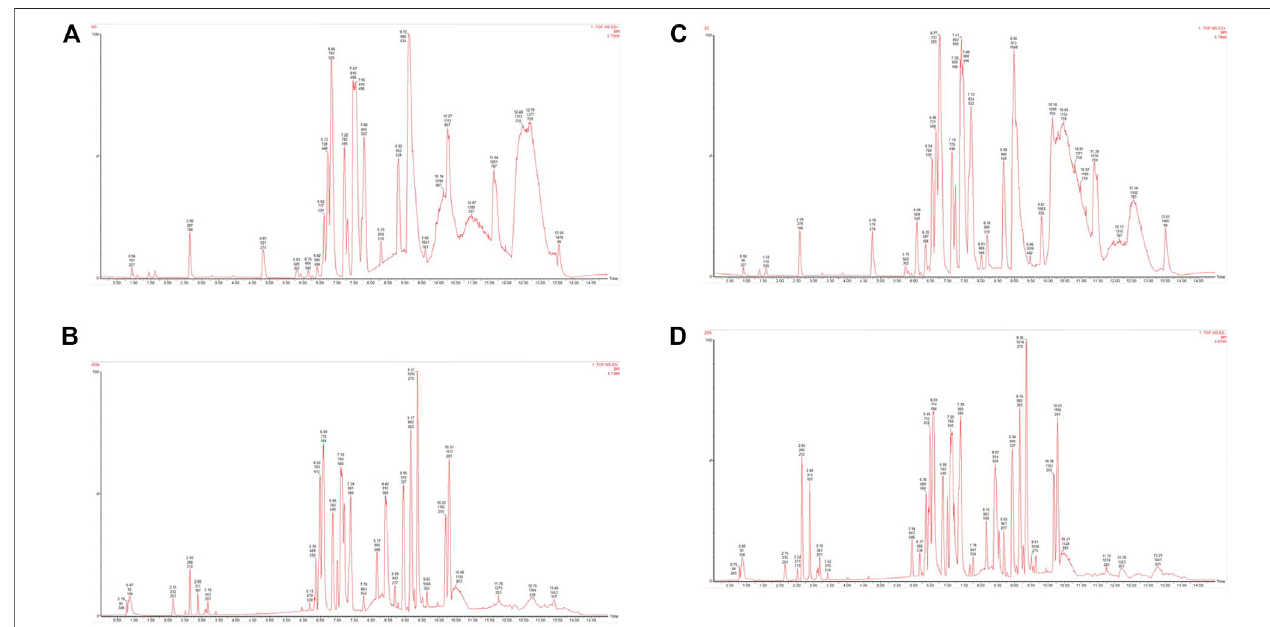
FIGURE 4 | Representative BPI chromatograms of serum samples derived from the model group ( (A) . positive; (B) . negative) and control group ( (C) . positive; (D) . negative).